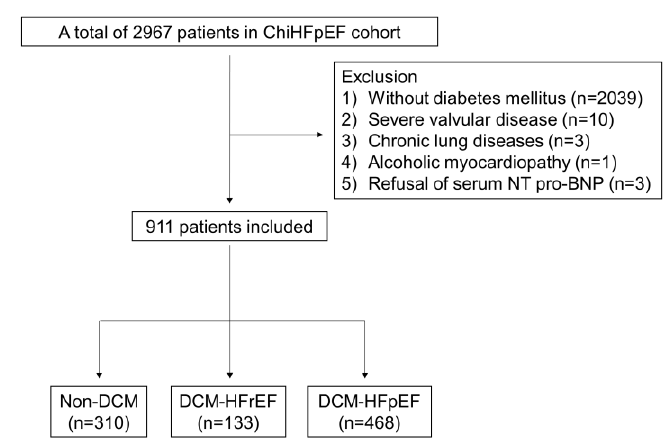
Figure 1. Patient flowchart. DCM: diabetic cardiomyopathy; HFrEF: heart failure with reduced ejection fraction; HFpEF: heart failure with preserved ejection fraction.